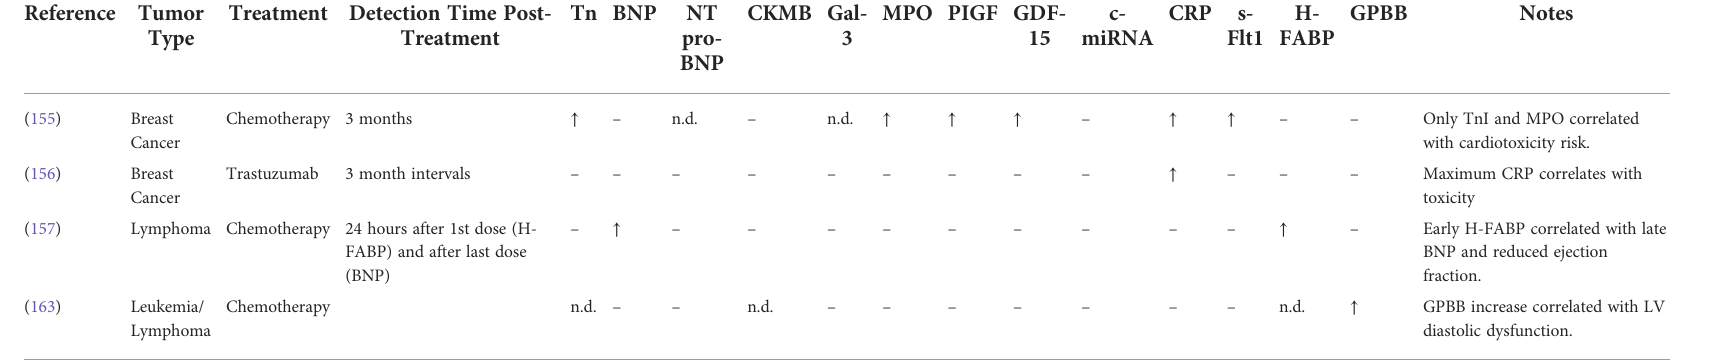
TABLE 2 Summary of putative markers of cardiac toxicity associated with cancer